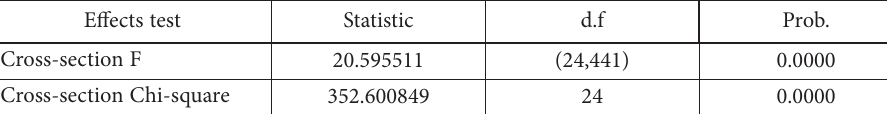
Table 2. Summary of the Redundant Fixed Effects test